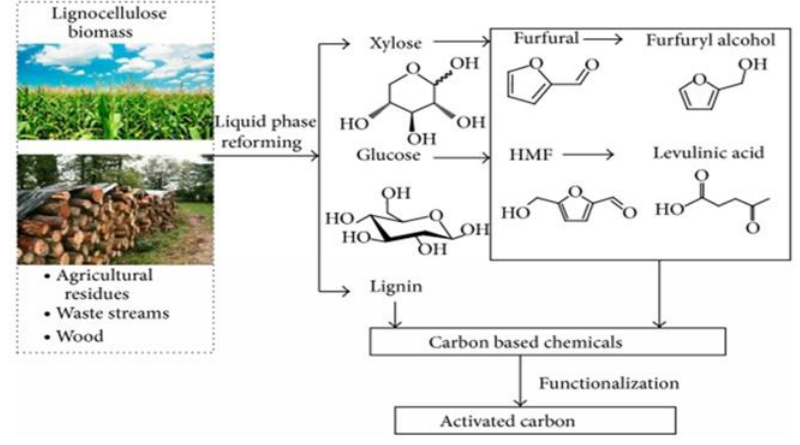
Figure 4. The route of AC derived from biomass. Adapted with permission from ref. [23].